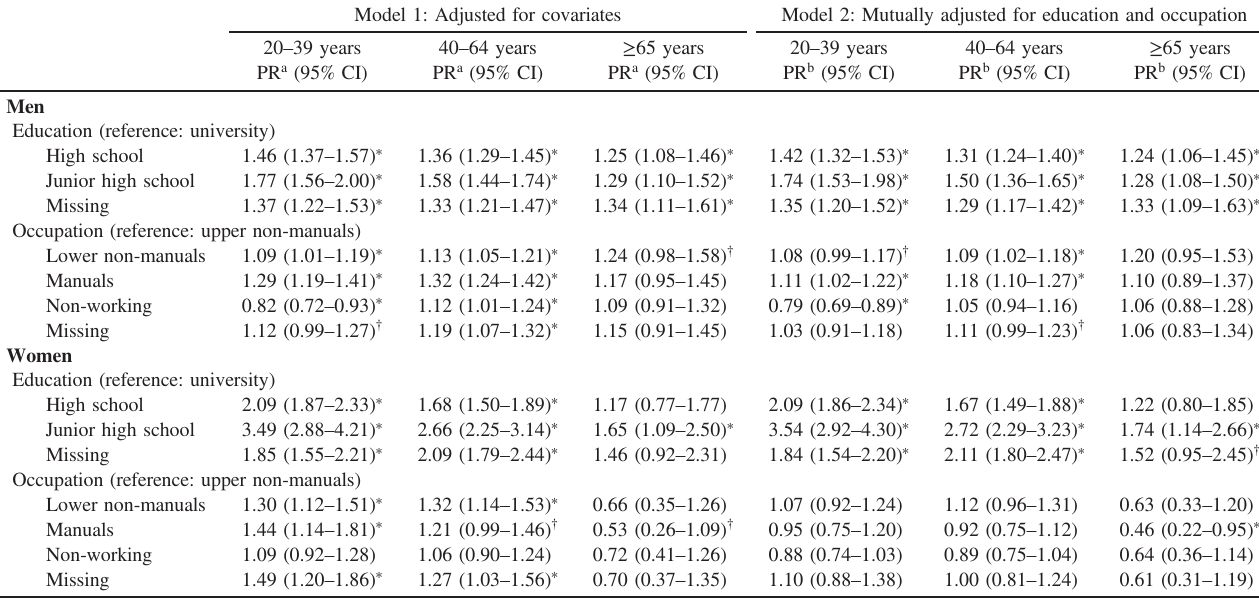
Table 3. Adjusted prevalence ratio for current smoking according to education and occupation, strati fi ed by age and gender Model 1: Adjusted for covariates Model 2: Mutually adjusted for education and